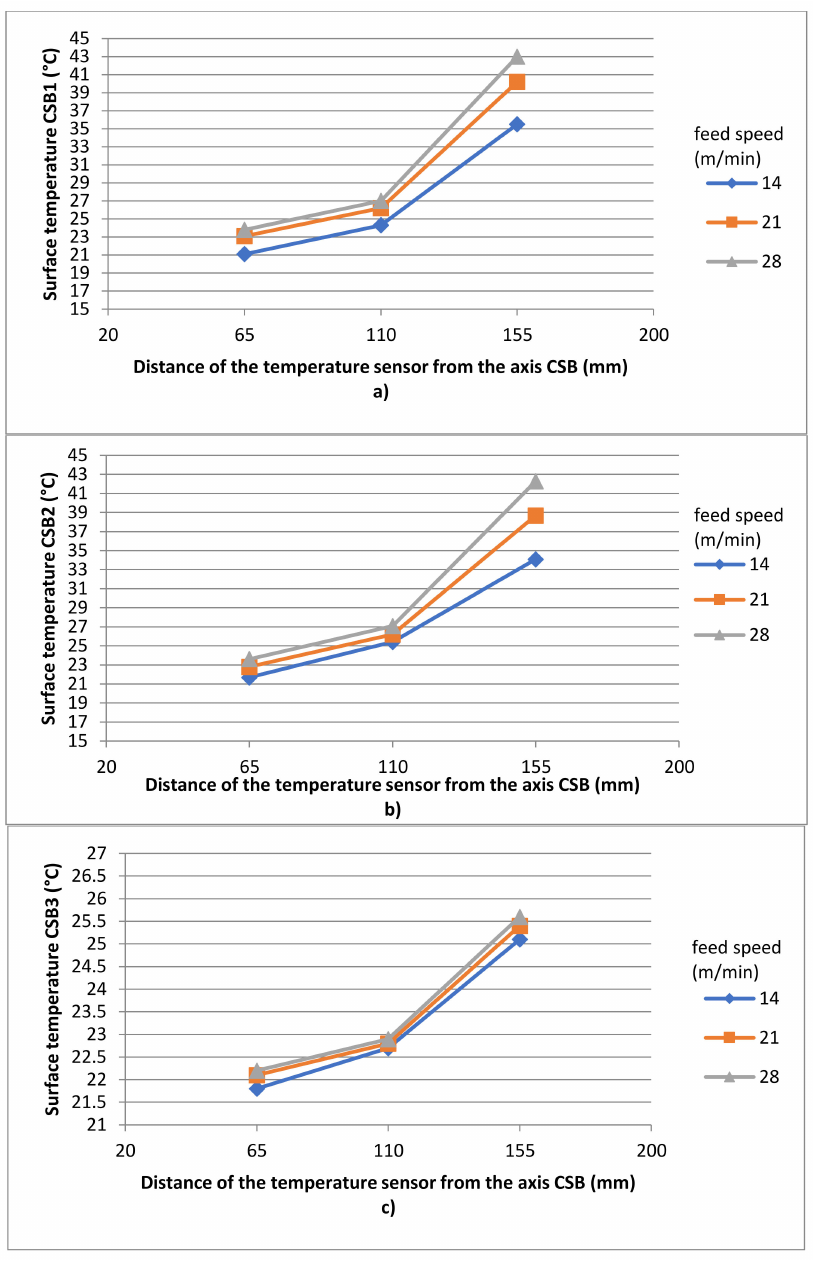
Figure 10. Dependence of the circular saw blade surface temperature on the distance of the sensor from the saw blade axis at a shaft speed of 4100 rev/min: ( a ) CSB1, ( b ) CSB2, and ( c ) CSB3. As we can see from Figure 10, the surface temperatures of the circular saw blades CSB1 and CSB2 had values at about 21 ± 0.5 ◦ C at the sensor position of 65 mm from the shaft axis (near the flanges). These temperatures increased slightly with increasing feed speed to values of 23–24 ◦ C. Based on experimental measurements, the authors of [30,40,41] reported similar temperature values in the range of 22–24 ◦ C for the area of clamping flanges. At the position of the temperature sensor of 110 mm from the shaft axis, the surface temperatures of the discs have already increased significantly to values of 24–25 ◦ C. These temperatures also changed with increasing feed speed. At the last position of the sensor closest to the heel circle of the teeth (R = 155 mm) from the shaft axis, the surface temperature of the